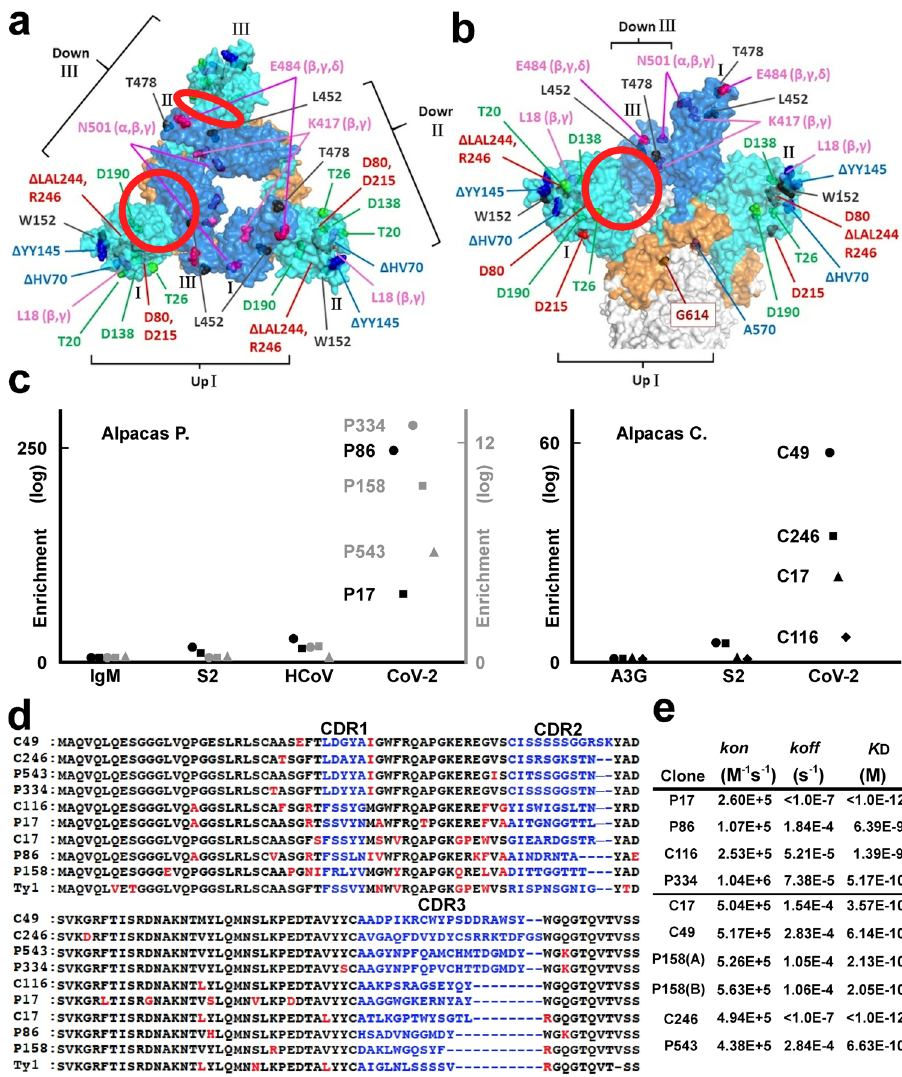
Fig. 1 Structural features of the SARS-CoV-2 spike and the panel of nanobodies. a , b Top ( a ) and side ( b ) views of the 1-up + 2-down conformation of the SARS-CoV-2 spike trimer 95 (PDB entry: 7KRR); domains of each protomer numbered I (up), II (down) and III (down). The NTD, the RBD and the C-terminal domain (CTD) of the SARS-CoV-2 S1 domain are coloured cyan, blue, and orange, respectively; mutations and deletions studied here are indicated; clefts between the down-RBD and the NTD of the neighbouring protomer are highlighted with red circles. c Graphs showing existence ratios (two different scales drawn black and grey) — P values in log 10 are plotted (see ‘ Methods ’ ) — after panning with IgM; APOBEC3G (A3G) 26 ; the S2 domain (S2); the HCoV-OC43 (HCoV) spike 27 ; and the SARS-CoV-2 spike (CoV-2). d Sequences of nine clones and that of Ty1 are compared 37 : changed amino acids in the framework regions are red; the variable complementary-determining regions (CDRs) are shown in blue. e Calculated binding kinetics between each nanobody and the SARS-CoV-2 spike from sensorgrams (see Supplementary Fig. 3) are summarized. The upper four clones were assayed in a high- salt buffer ( “ stabilized ” spike); the others were assayed in an anionic buffer ( “ fl uctuated ” P158, P334 and P543 clones speci fi cally detected SARS-CoV-2 spike proteins with the same sensitivity as the mouse monoclonal C9-tagged antibody (Fig. 2a). The banding patterns suggested that each clone recognized a part of the S1 domain. These clones (P158, P334 and P543) detected SARS-CoV-2 spike variants — including Alpha and Beta variants — via western blotting.